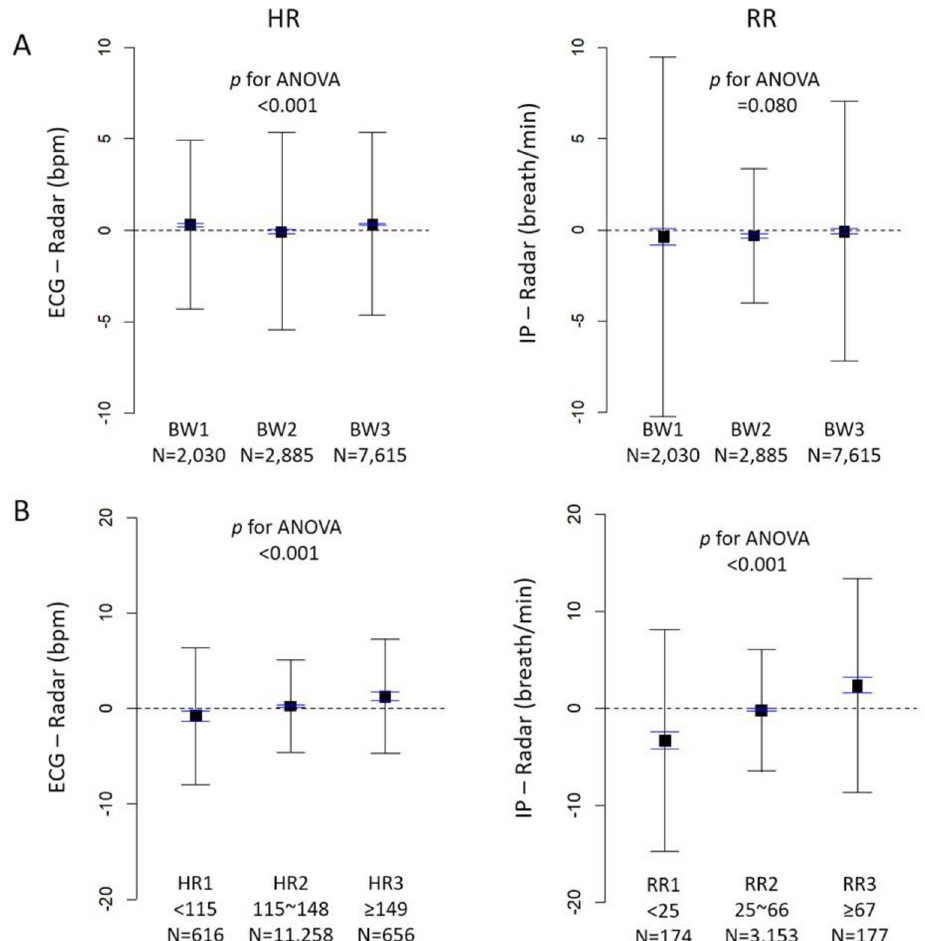
Fig 6. Agreement of RR and HR between IR-UWB radar and ECG/IPG according to BW, HR and RR. The means biases (boxes), 95% LOAs (black whiskers) and 95% CI of the mean biases (blue whiskers) were plotted according to BW, HR and RR. A) Although the biases between the two methods are significant for RR in the BW2 group (p < 0.001) and for HR in the BW1 (p < 0.001) and BW3 (p < 0.001) groups in one-sample t-tests, the absolute biases are less than 1 in both HR and RR in all groups. Biases in HR are smallest in the BW2 group while biases in RR are not different among the BW groups. B) Biases are smallest in the HR2 category and RR2 category. The mean biases are significant in all categories. The radar measurements of HR and RR was higher in the low HR and RR range and lower in the high HR and RR range than the conventional measurements. that of the current standard monitoring technique used in neonates. Although extracting rapid heartbeats with a tiny magnitude of the chest wall of neonates is difficult, we successfully iso- lated HR from the respiration harmonics using a new algorithm for neonates [19, 20]. The patches and wires of conventional vital monitoring equipment can not only cause mis- reading of X-ray films but are also a major obstacle to parent-child bonding [2, 9]. Anand and Scalzo [28] suggested that pain, stress and maternal separation of NICU patients have a nega- tive impact on cognitive development [29]. In addition, a study by Chen et al. [30] indicated that stressful conditions, such as repetitive application and removal of patches, adversely affect an infant’s well-being and developmental outcomes [31], and the resulting scars may be disfig- uring or disabling in 10% of preterm infants [13]. Considering the above findings, a contactless vital sign monitoring technique would be highly desirable.